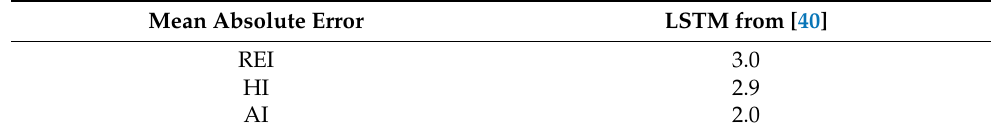
Table 9. Mean absolute error for REI, HI and AI estimation from